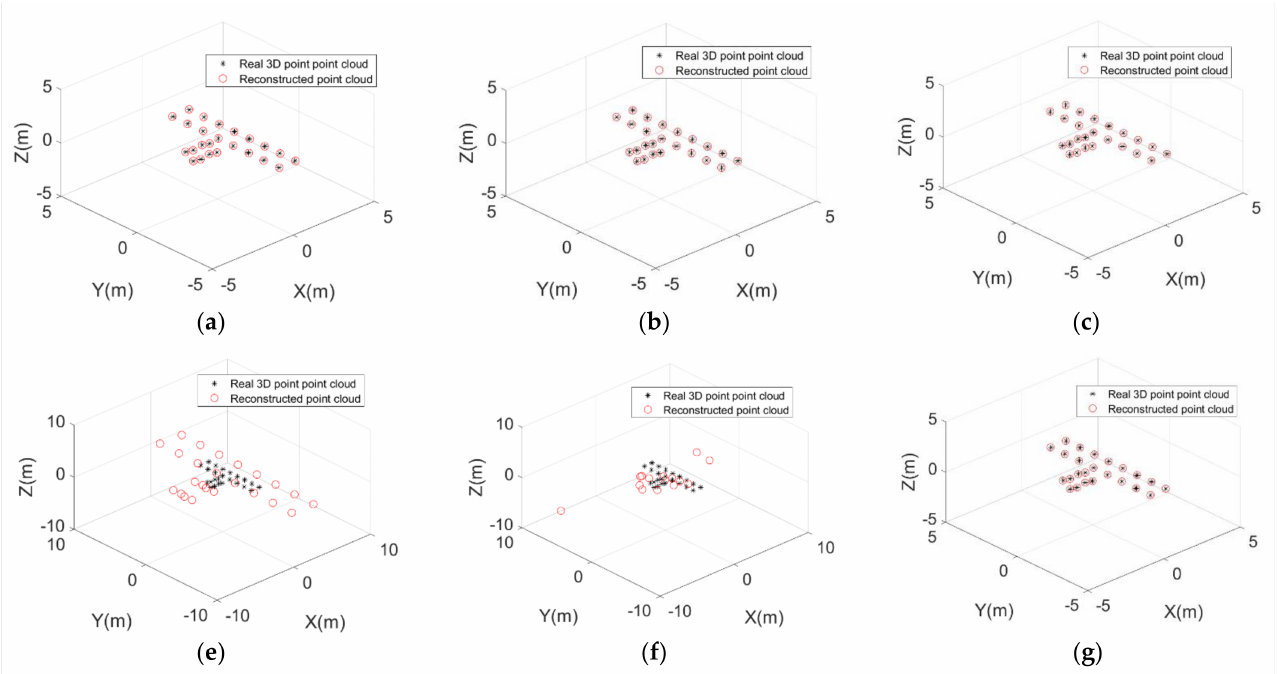
Figure 9. 3D geometry reconstructed results of the point model. ( a ), ( b ), and ( c ) show the factorization method, ISEA method, and the proposed method, respectively, when the space target is triaxially stabilized. ( d ), ( e ), and ( f ) show the factorization method, ISEA method, and the proposed method, respectively, when the space target is slowly rotating around a fixed